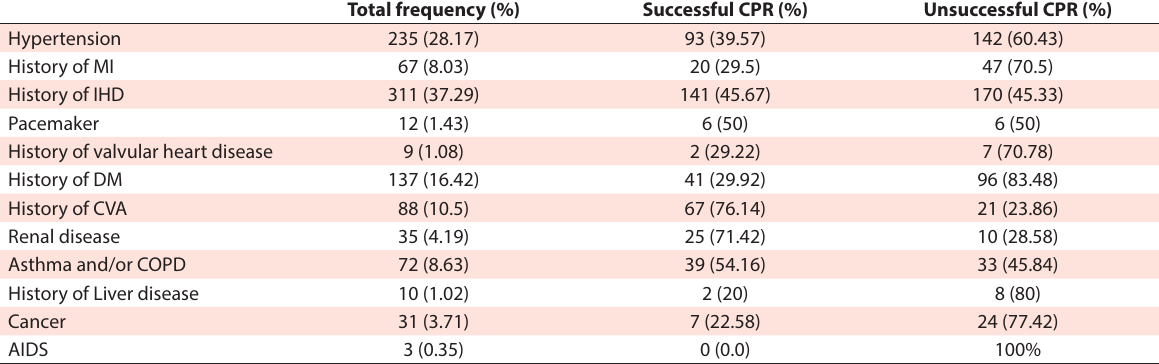
Table 2. Different Medical problems among patients and different CPR outcome in each